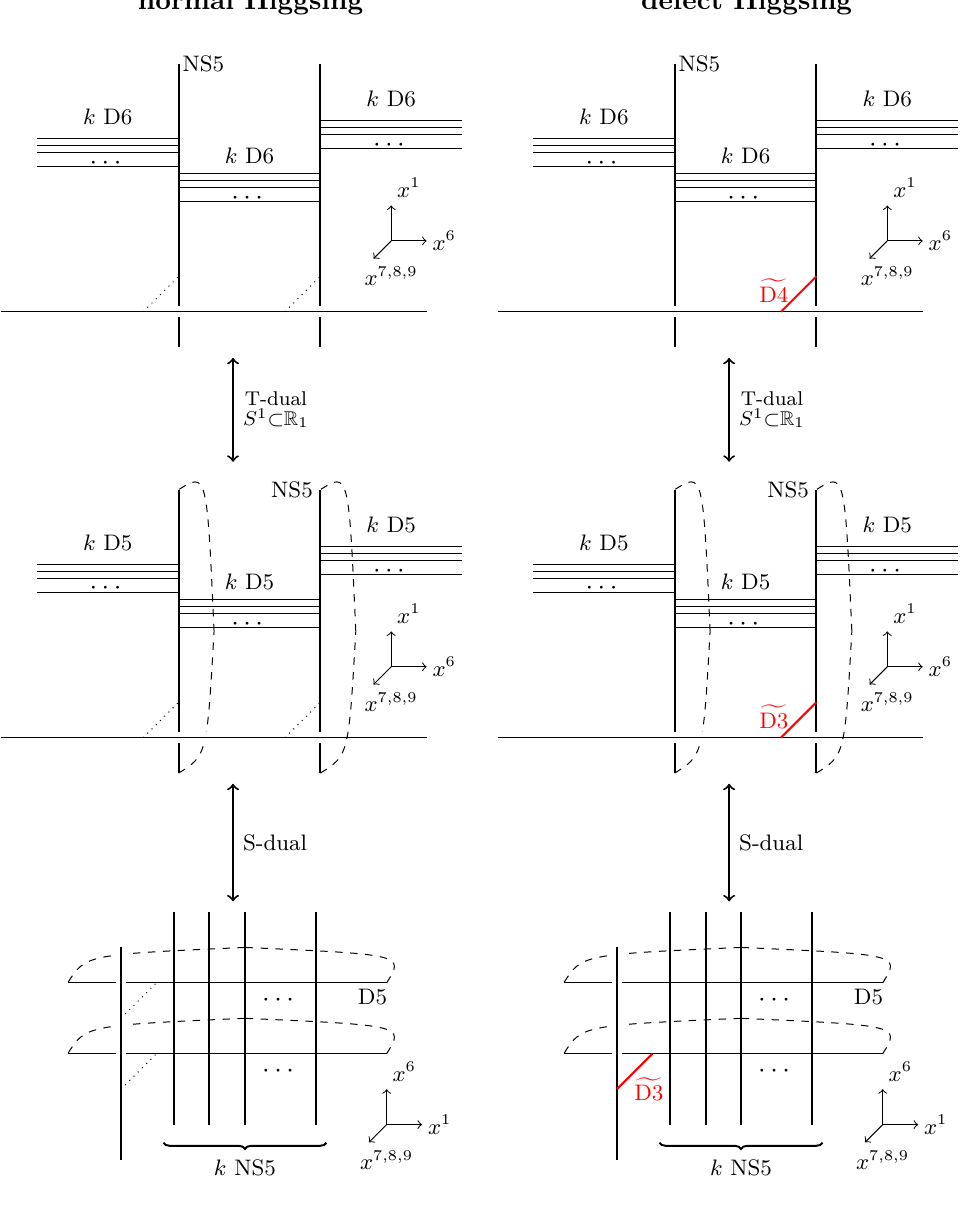
Figure 1 . Higgsing in the brane configuration of table 1. The mesonic Higgsing of the 6d theory SU( k +1) with N f = 2 k +2 to SU( k ) with N f = 2 k , is realised by moving one D6 away along the x 7 , 8 , 9 direction. For the dual 5d theory, the corresponding baryonic Higgsing of the affine A k quiver to the affine A k − 1 quiver is realised by moving one NS5 brane along x 7 , 8 , 9 . A codimension 2 defect for the 6d brane configuration is introduced via a f D4 brane that is attached to the D6 brane which is moved along x 7 , 8 , 9 . In the dual 5d system this becomes a f D3 brane suspended between the 5-brane web and the NS5 that is displaced in x 7 , 8 , 9